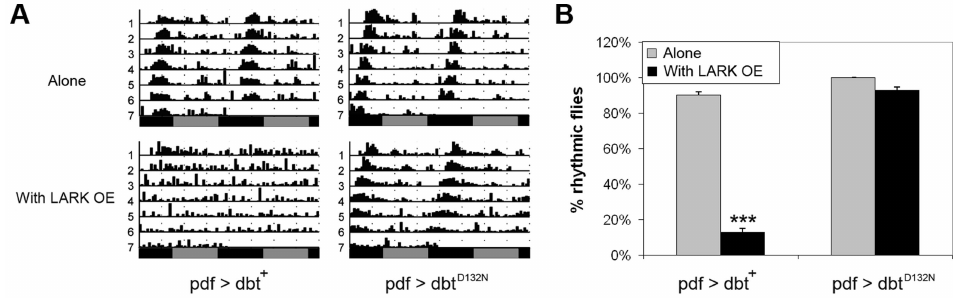
Figure 7. DBT kinase activity is required for the LARK OE phenotype. A: Representative actograms showing that overexpression of wild-type DBT protein ( pdf . dbt ) enhances the LARK OE phenotype (producing arrhythmicity) whereas overexpression of a mutant DBT protein lacking kinase activity ( pdf . dbt D132N ) suppresses the period-lengthening effect of LARK OE. B: Quantification of percentage rhythmicity in flies overexpressing DBT proteins with or without LARK OE. Genotypes are pdf . dbt alone: pdf-gal4/ + ; uas-dbt/ + (n=31). pdf . dbt with LARK OE: pdf-gal4/ + ; uas-dbt/Tub-gal80 ts uas-lark (n=31). pdf . dbt D132N alone: pdf-gal4/ + ; uas-dbt D132N / + (n=42). pdf . dbt D132N with LARK OE: pdf-gal4/ + ; uas-dbt D132N /Tub-gal80 ts uas-lark (n=14). *** p , 0.0001 by Chi-square